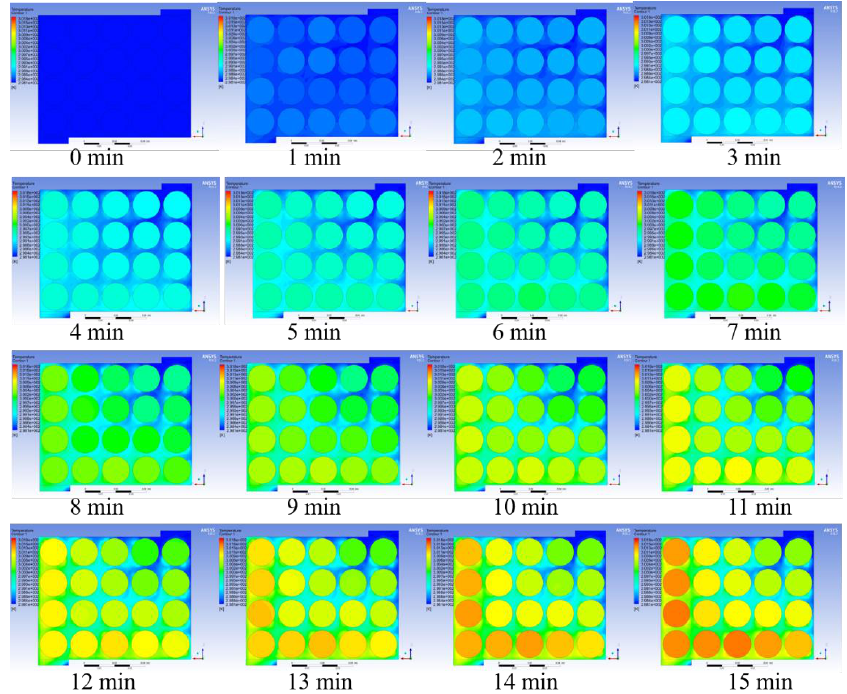
Figure 24. A temperature field change in scheme 13 in the dying minutes.